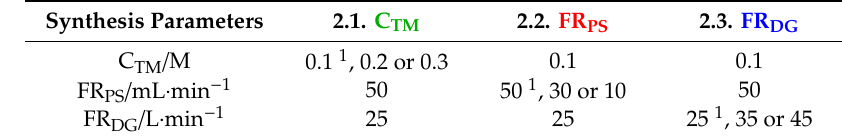
Table 1. Summary of the condition variations for the Ba 0.5 Sr 0.5 Co 0.8 Fe 0.2 O 3- δ (BSCF) production to investigate the three flame spray synthesis parameters—total metal concentration ( C TM ) in the precursor solution measured in mol · L − 1 or M, flow rate of the precursor solution ( FR PS ) measured in mL · min − 1 and flow rate of the dispersion gas ( FR DG ) measured in L · min − 1 . The results of the e ff ect of each parameter on BSCF are presented in Sections 2.1–2.3.